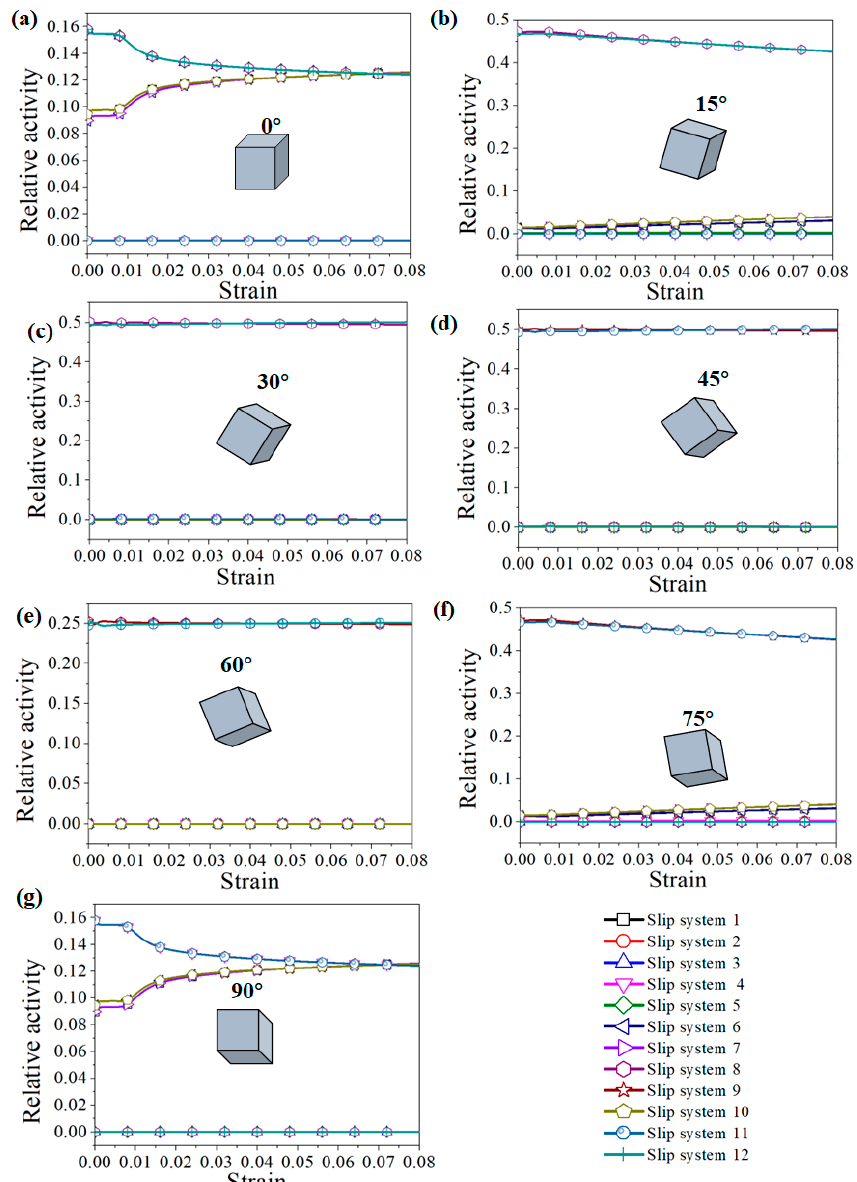
Figure 12. Activation of the slip systems of grains with different orientations during the tension process: ( a ) 0°, ( b ) 15°, ( c ) 30°, ( d ) 45°, ( e ) 60°, ( f ) 75°, and ( g ) 90°. process: ( a ) 0 ◦ , ( b ) 15 ◦ , ( c ) 30 ◦ , ( d ) 45 ◦ , ( e ) 60 ◦ , ( f ) 75 ◦ , and ( g ) 90 ◦